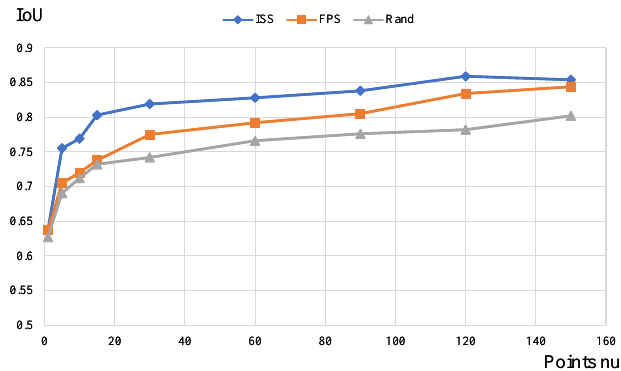
Figure 15. Component segmentation accuracy of three point selection